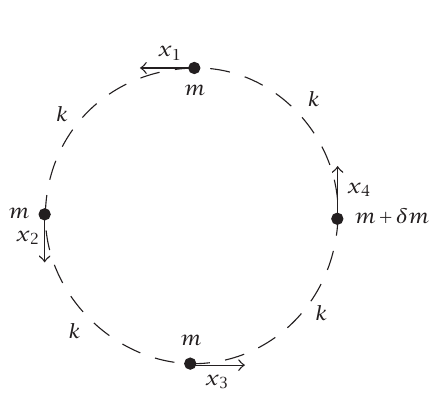
Figure 3.1 . Four particles with their mass symmetry